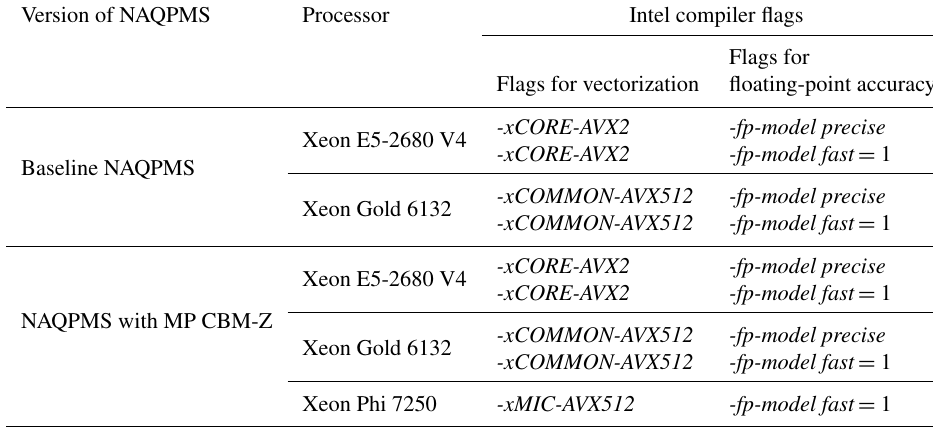
Table 3. Compile flags of the different versions of NAQPMS. Version of